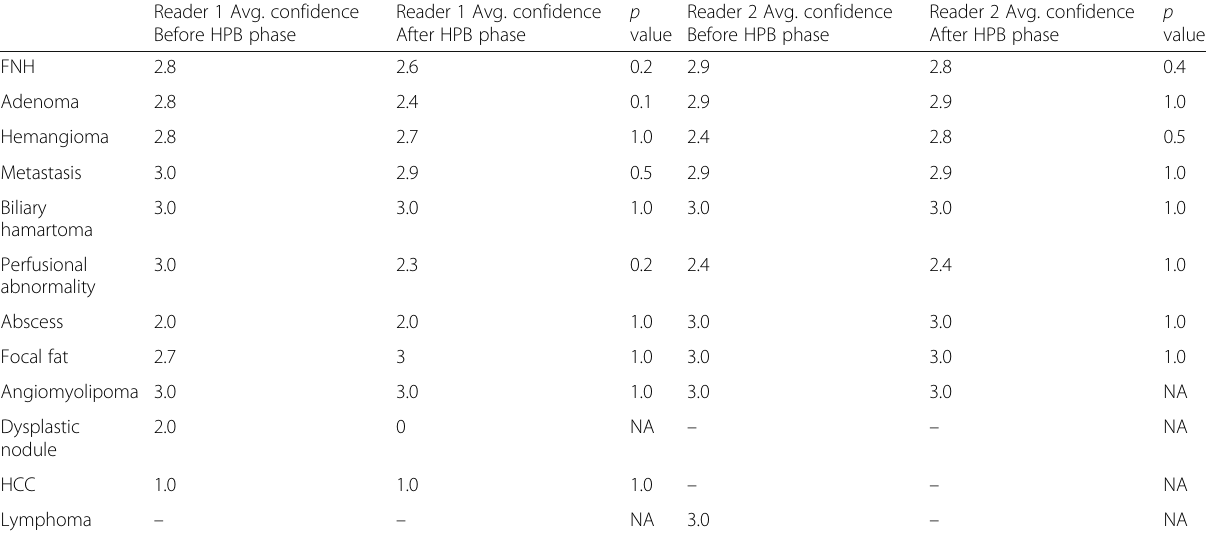
Table 4 Reader characterization of lesions before and after evaluation of the HPB phase and change in confidence